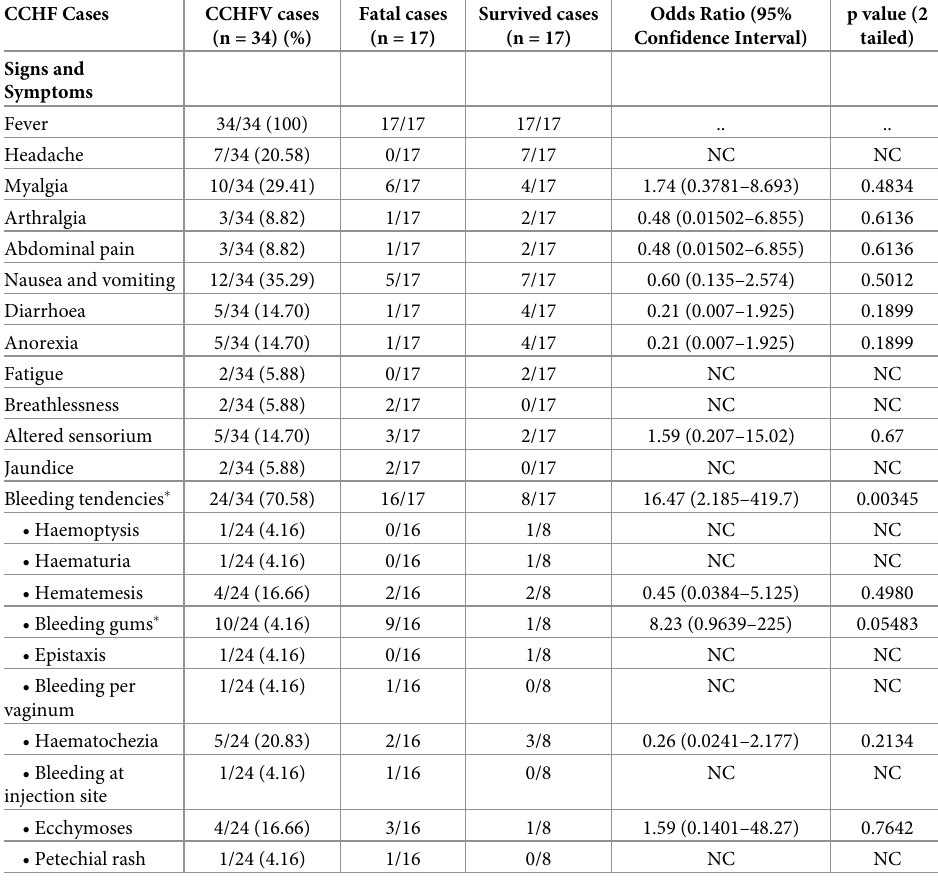
Table 2. Clinical presentation of fatal and survived CCHFV